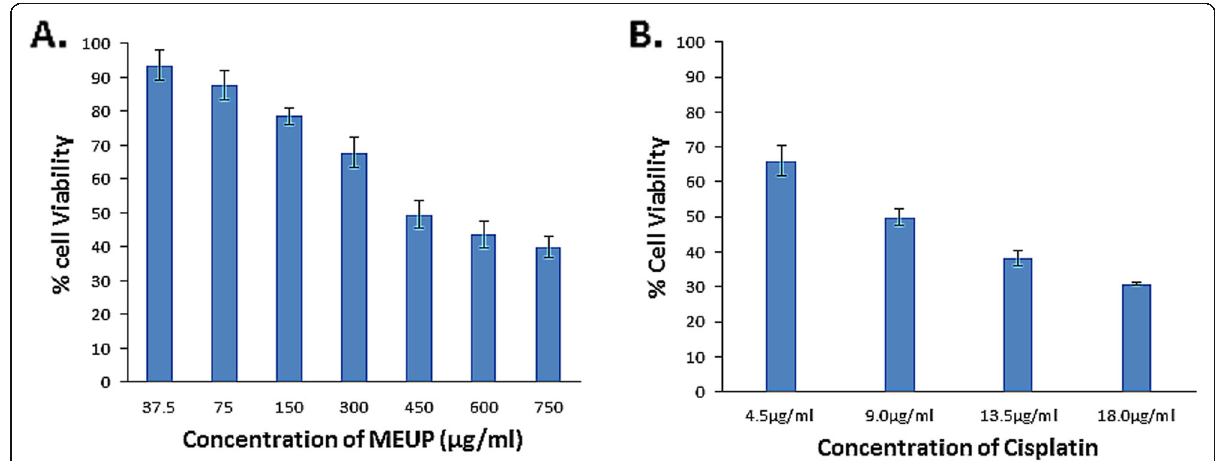
Fig. 1 Effects of MEUP ( a ) and cisplatin ( b ) on viability of A549 human lung cancer cells measured by MTT assay. Cells were cultured in varying concentrations of MEUP and Cisplatin. Reduction in cell viability was observed with increasing concentration of MEUP and Cisplatin. Results are expressed as mean ±